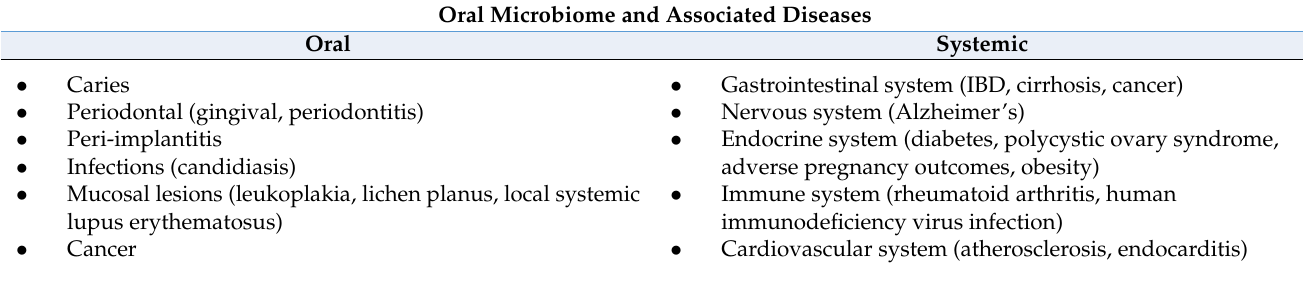
Table 1. The main diseases associated with dysbiosis of the human